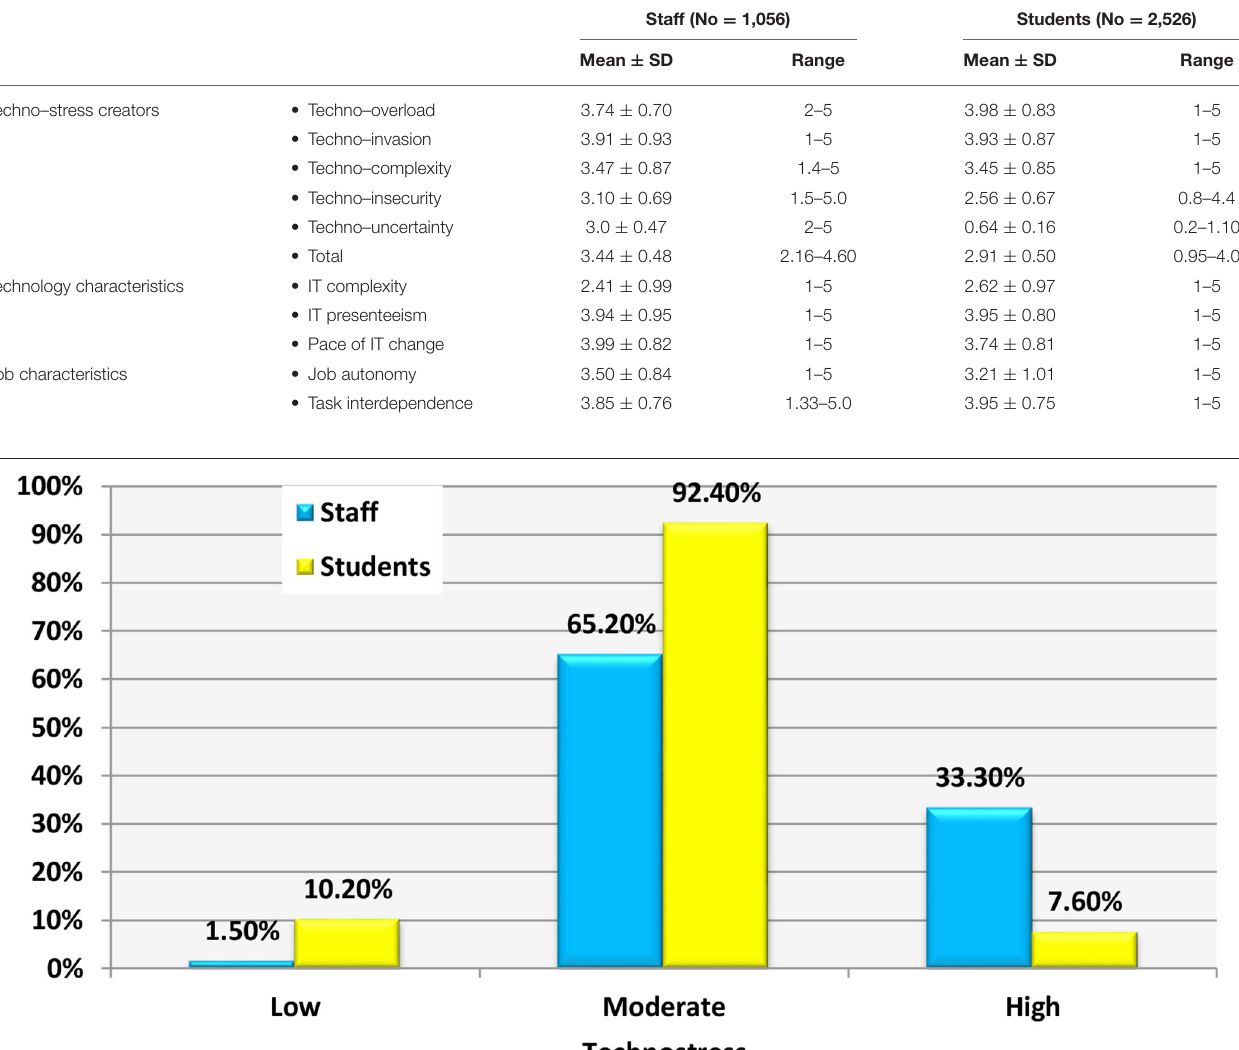
TABLE 2 | Technostress creators, job and technology characteristics among the studied staff and students.